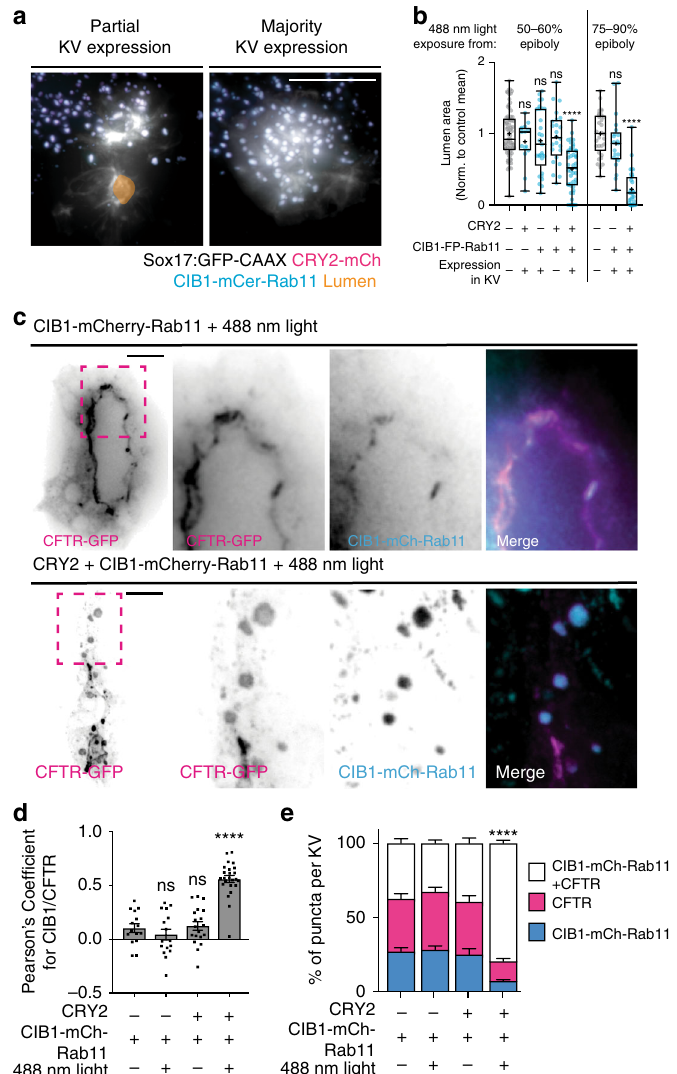
Fig. 6 Optogenetic clustering of Rab11 during KV development results in abnormal lumen formation and perturbed polarity establishment. a Representative 3D renderings of KV under conditions of CRY2-mCherry/CIB1-mCerulean-Rab11 plus 488 nm light with partial (top) or majority KV mRNA expression (bottom). 3D rendering with lumen trace (orange), cell membrane (GFP-CAAX, white), CRY2-mCherry (magenta), and CIB1-mCerulean-Rab11 (cyan) shown. Bar, 50 μ m. b Box and whisker plot depicting two-dimensional lumen area normalized to uninjected control values plus or minus 488 nm light beginning at 50 – 60% epiboly (left, n > 15 embryos) or 75 – 90% epiboly (right, n > 21 embryos). Dots represent individual KV values. Whiskers denote minimum and maximum values, 25th and 75th percentiles denoted by box boundaries. Median denoted by line within box and mean denoted by plus sign. One-way ANOVA with Dunnett ’ s multiple comparison test, compared with uninjected embryos. Statistical results detailed in Supplementary Table 5. c Representative 3D renderings of KV in CFTR-GFP (magenta) embryos under conditions of CIB1-mCherry-Rab11 (cyan, top) or CRY2 + CIB1-mCherry- Rab11 (cyan) + 488 nm light exposure (bottom). Dashed box represents insets shown at the right. Bars, 20 μ m. d Bar graph depicting the Pearson ’ s coef fi cient for CFTR-GFP and CIB1-mCherry-Rab11 in embryos treated plus or minus 488 nm light exposure. ANOVA with Dunnett ’ s multiple comparison test, compared with embryos expressing CIB1-mCherry-Rab11 minus 488 nm exposure. Statistical results detailed in Supplementary Table 5. Mean displayed± SEM. Dots represent individual values. e Bar graph depicting the percentage of puncta per KV expressing CFTR-GFP (magenta), CIB1-mCherry- Rab11 (cyan), or both (white). One-way ANOVA with Dunnett ’ s multiple comparison test completed for each cluster type, compared with percentages from embryos expressing CIB1-mCherry-Rab11 under normal light conditions. Statistical results detailed in Supplementary Table 5. d , e n > 10 embryos analyzed from fi ve experiments. Mean displayed ± SEM. Dots represent individual